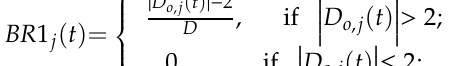
Figure 10. Multiple groups of particle searching in the solution space.